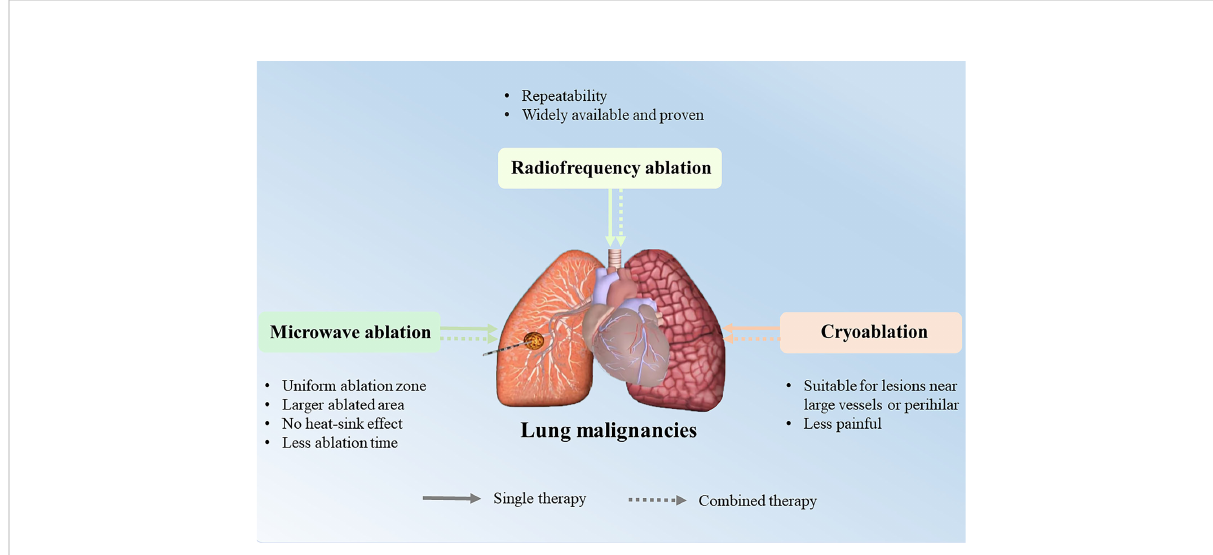
FIGURE 1 A graphical representation of the summary of the technology. Three ablation modalities: radiofrequency ablation, microwave ablation and cryoablation alone or in combination with other treatment modalities for lung malignancies, and their respective